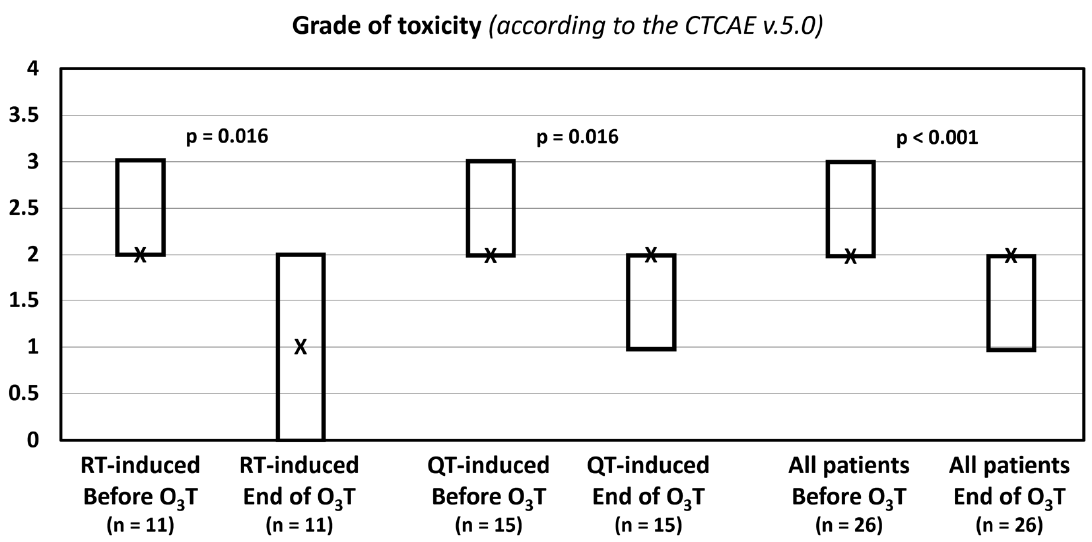
Figure 2. Grade of toxicity according to the Common Terminology Criteria for Adverse Events (CTCAE v.5.0) of the National Cancer Institute of EEUU. X: median value. Box: quartiles 1 and 3.